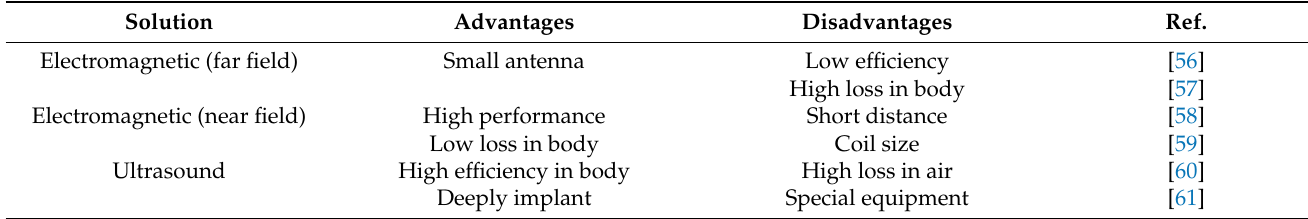
Table 6. Advantages and drawbacks between ultrasound and electromagnetic solutions.